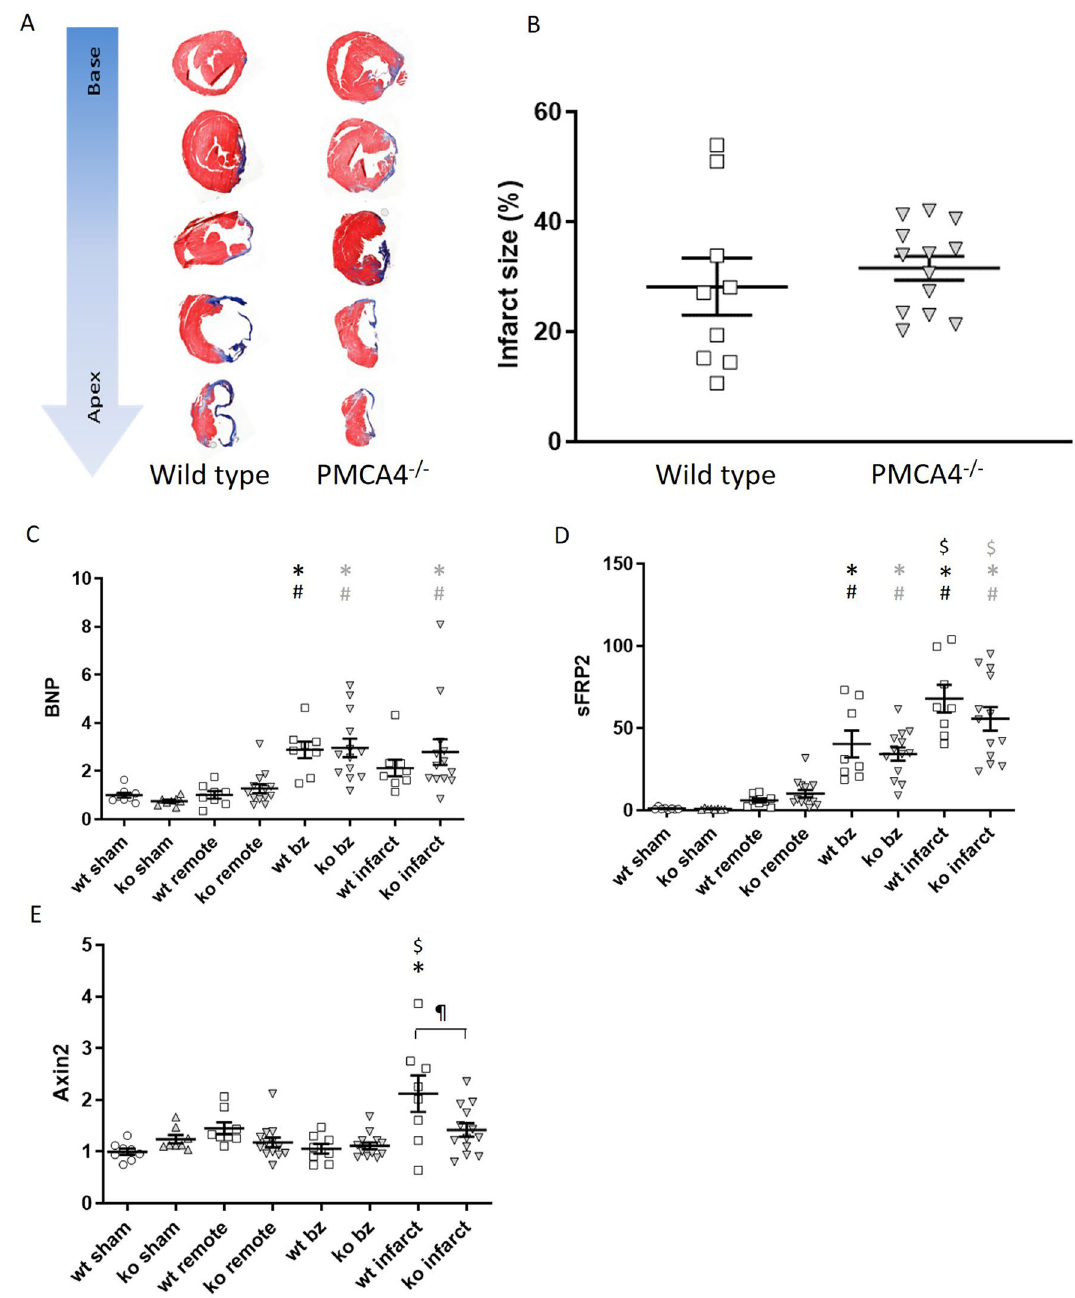
Figure 2. PMCA 4 global deletion does not affect chronic infarct size, remodelling or Wnt signalling post MI. ( A ) Representative masson’s trichrome stained sections from wildtype and PMCA4 −/− hearts following 6 weeks MI. Images were acquired using a 3D Histech Panoramic slide scanner and CaseViewer software version 2.4.0. ( B ) Quantification of infarct size measurements 6 weeks post-MI. WT n = 9, PMCA4 −/− n = 13. Regional gene expression was examined in WT (clear points) and PMCA4 −/− (grey points) hearts 6 weeks post sham or MI surgery for ( C ) Hypertrophic marker BNP ( D ) Wnt inhibitor sFRP2 and ( E ) Wnt transcriptional marker Axin2. bz = infarct border zone. Shams n = 8, WT MI n = 8, PMCA4 −/− MI n = 13. * p < 0.05 versus sham, # p < 0.05 versus remote, $ p < 0.05 versus border zone, ¶ p < 0.05 WT v KO